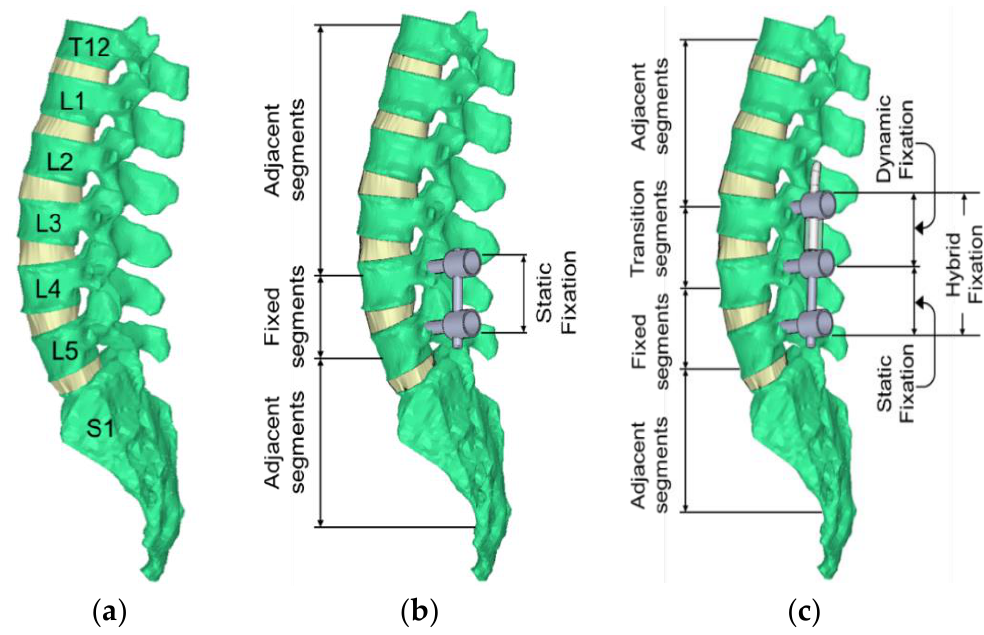
Figure 2. Depiction of spinal segments from T12 to sacrum (sagittal view): ( a ) intact specimen, ( b ) static fixation at L4/5 segments, and ( c ) hybrid fixation at L3–L5.